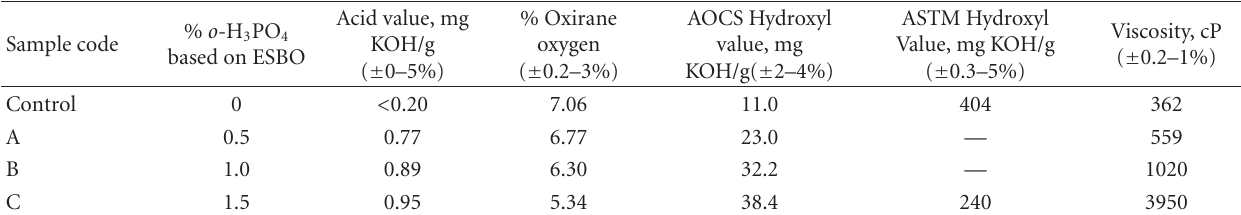
Table 3: Chemical properties of o -H 3 PO 4 -reacted ESBO (at RT) without solvent or alcohol source. Sample